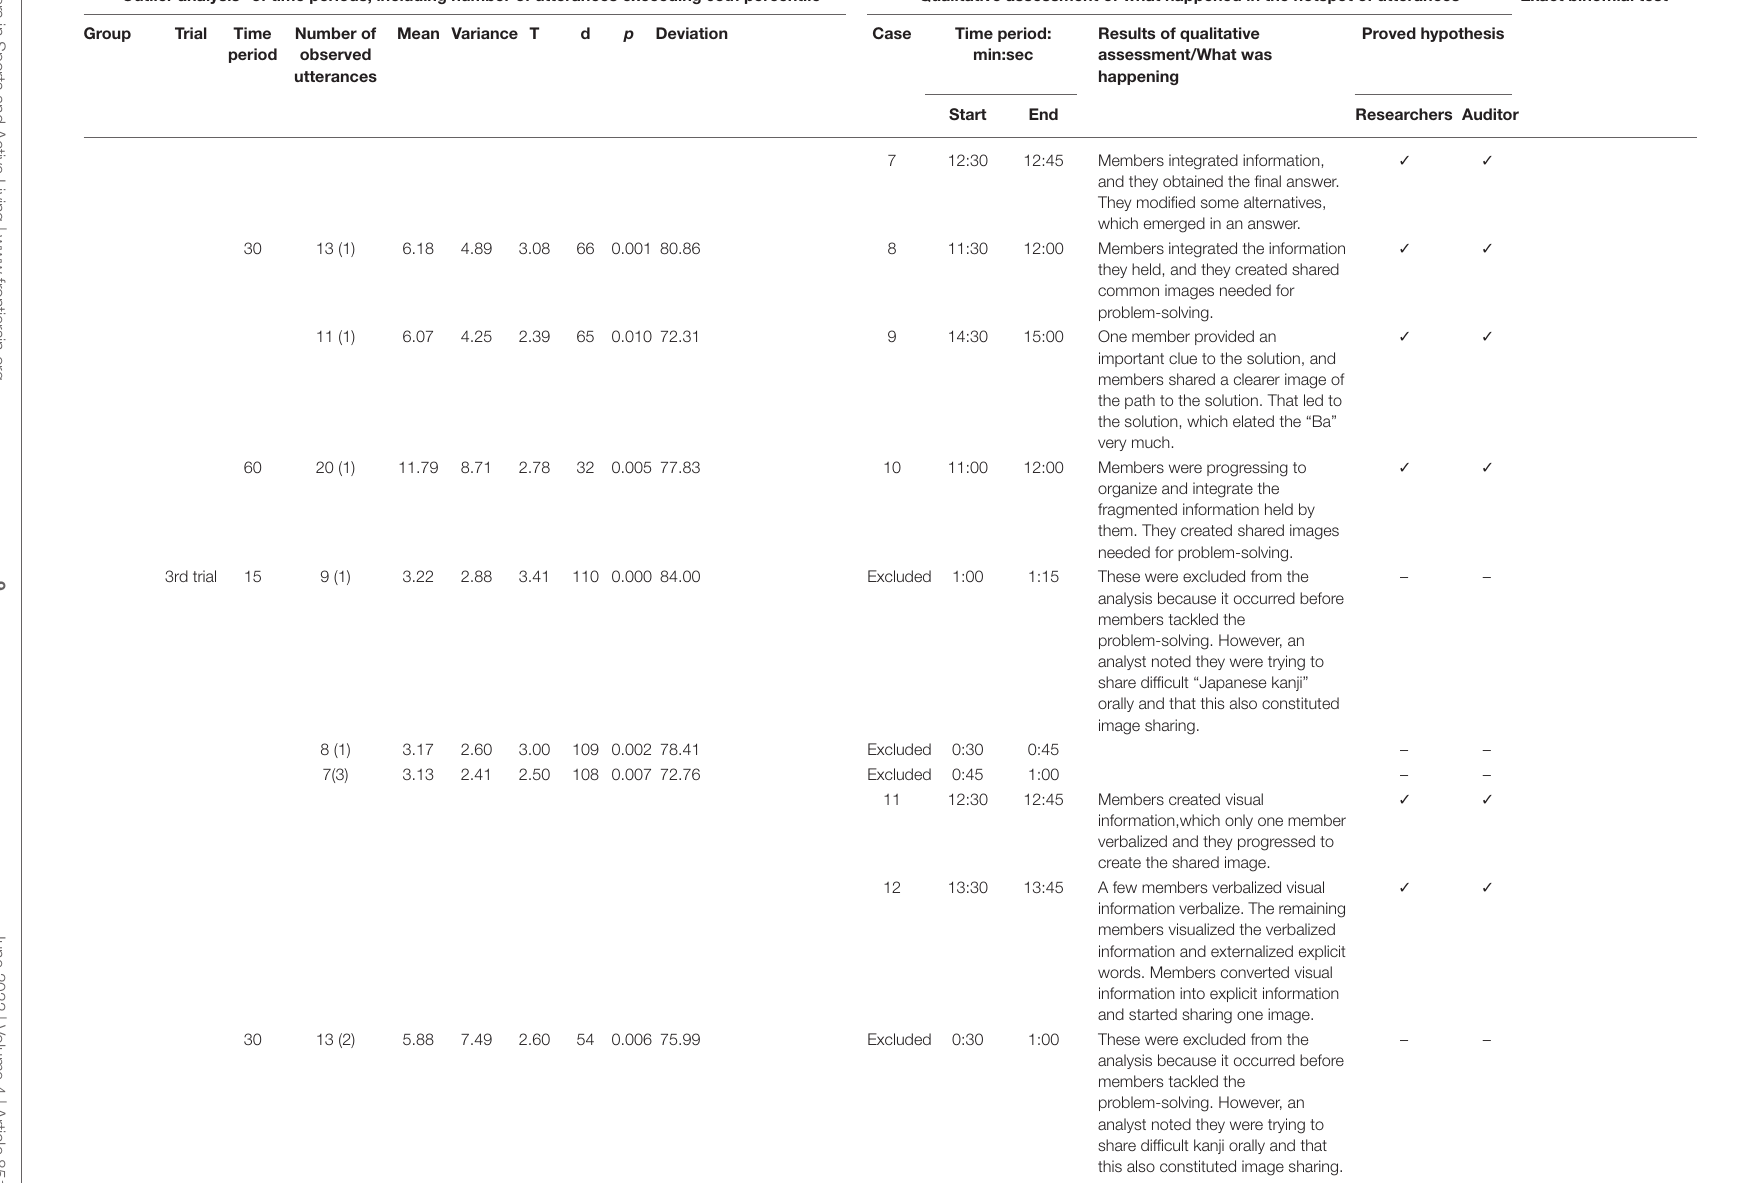
A few members verbalized visual information verbalize. The remaining members visualized the verbalized information and externalized explicit words. Members converted visual information into explicit information and started sharing one image. These were excluded from the analysis because it occurred before members tackled the problem-solving. However, an analyst noted they were trying to share difficult kanji orally and that this also constituted image